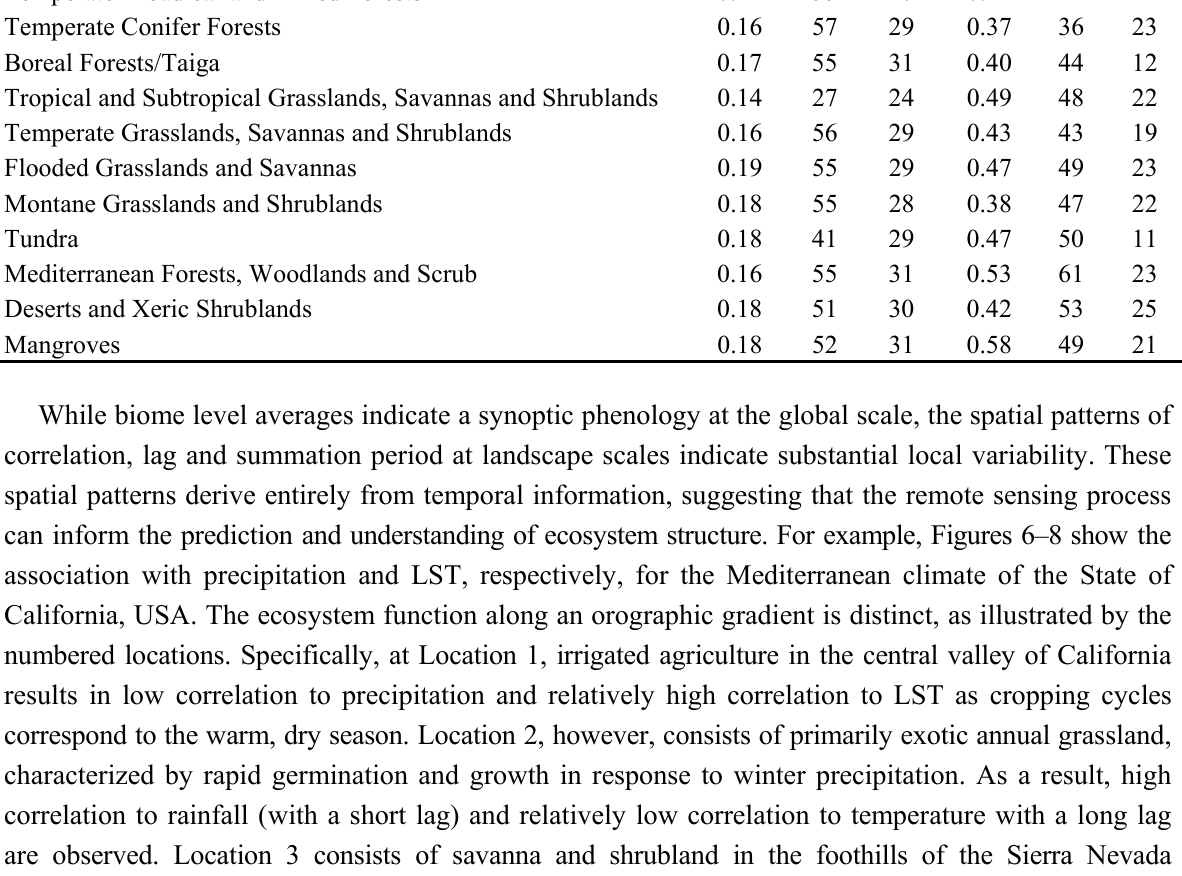
Precipitation Temperature Corr. Lag Sum Corr. Lag